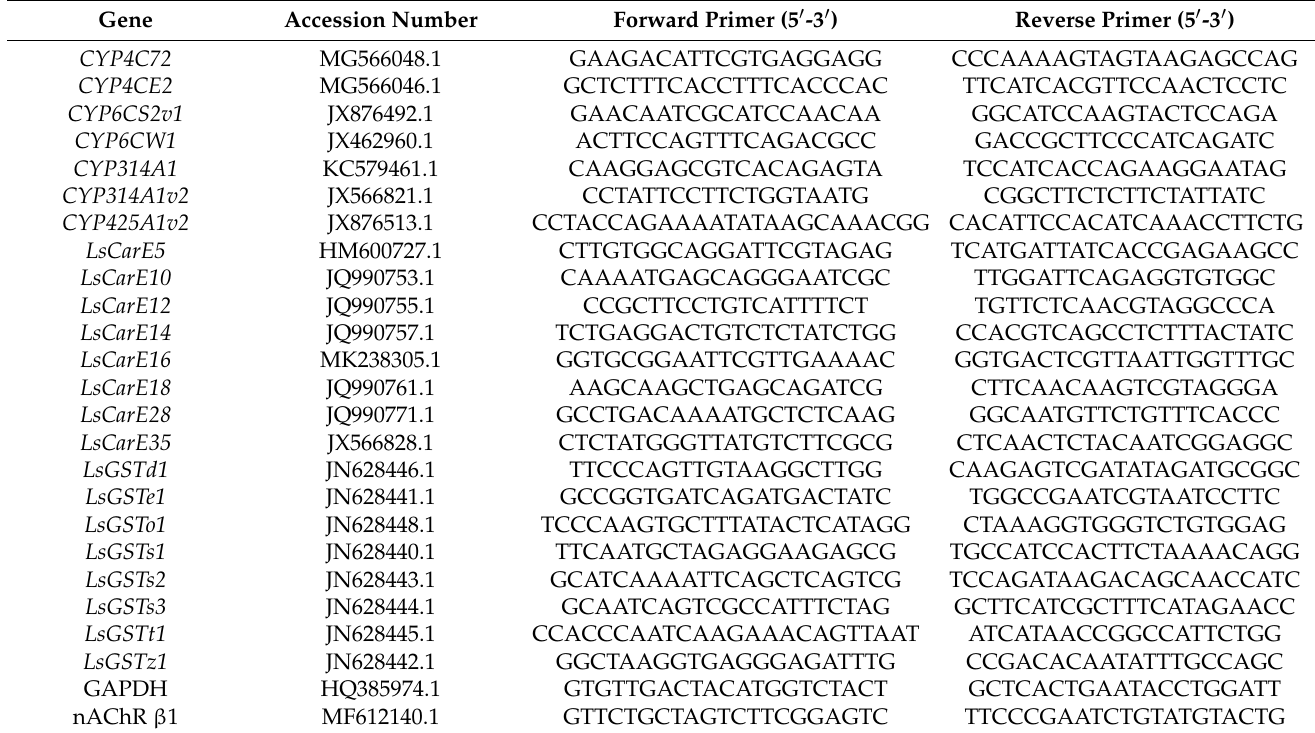
Table 1. Primers used for RT-qPCR and the nAChR β 1 subunit amplification.